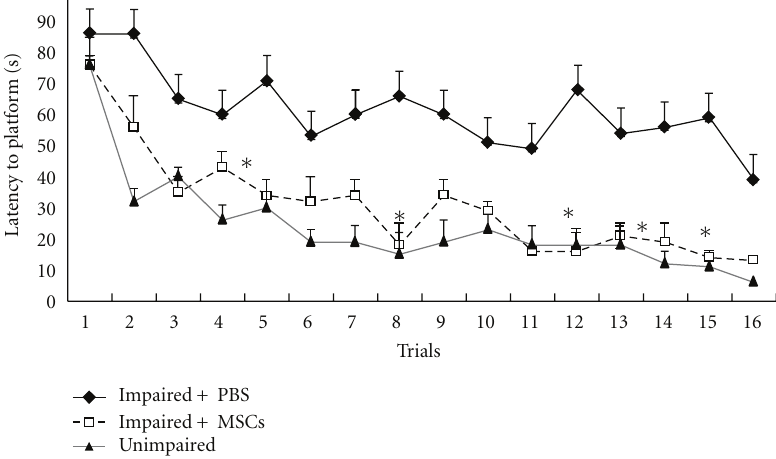
Figure 3: Comparisons of the acquisition performance on the Morris water maze task among the three groups. The results are the mean swimming time traveled per trial toward the platform. The mean values of the 16 trials for 4 days for each group are shown. Repeated measures of ANOVA for the swimming time among the groups were followed by Tukey’s test. ∗ P < 0 . 05 and ∗∗ P < 0 . 01 as compared with the corresponding data from the impaired +PBS group. Performance was assessed two months after the